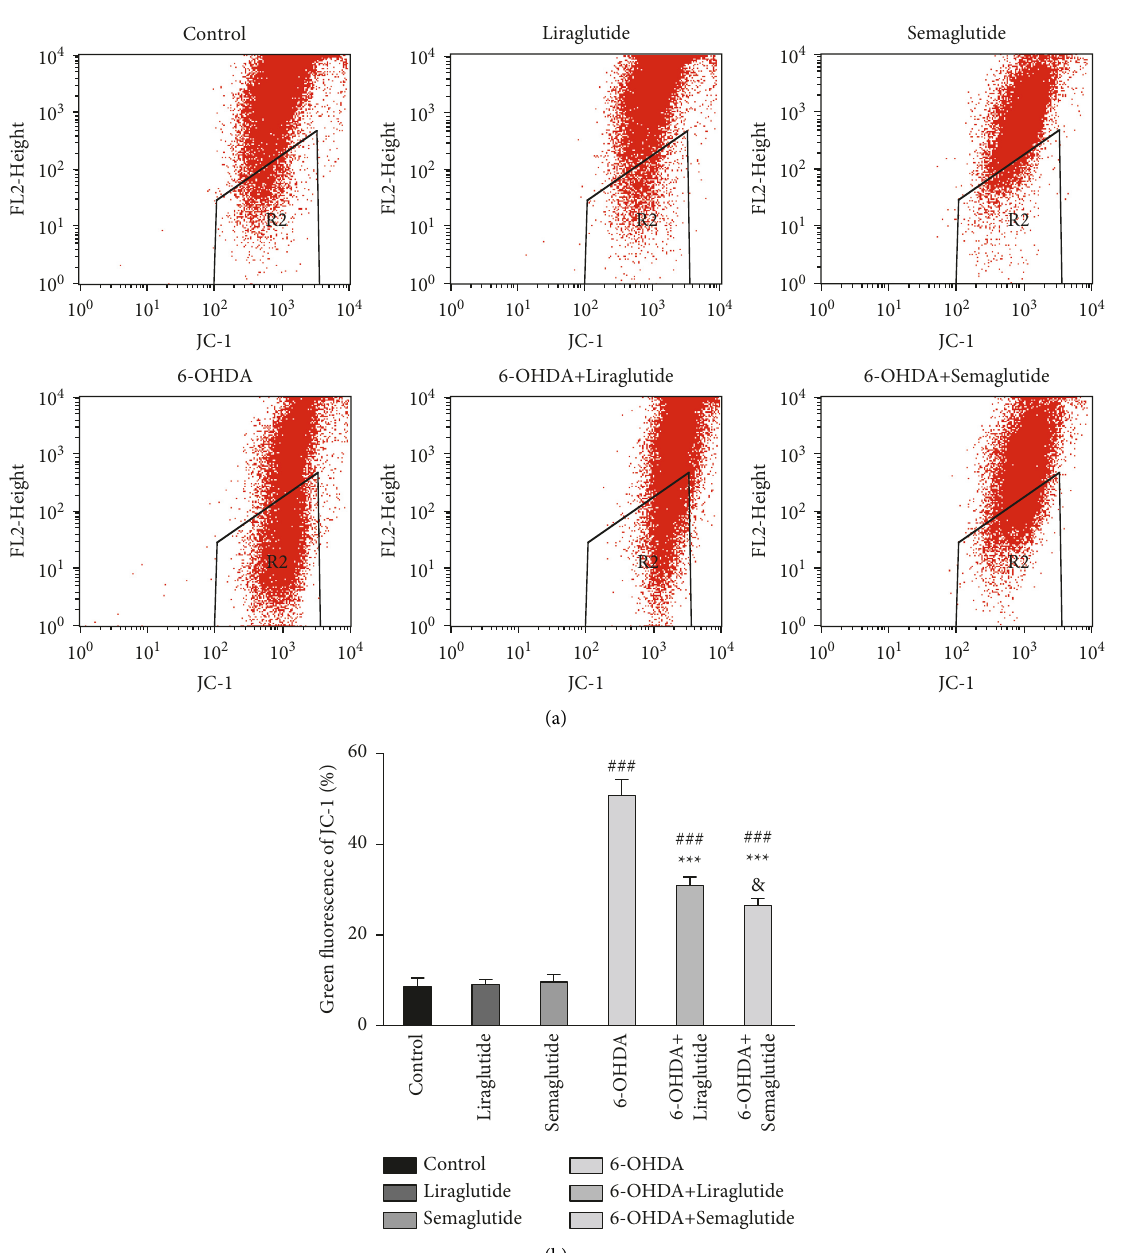
Figure 4: Changes in the m levels in SH-SY5Y cells. (a) Detection of the percentage of green fluorescence of JC-1 by flow cytometry. Green fluorescence indicates a low mitochondrial membrane potential ( OHDA group (### P 0 . 001 vs. the control group). Semaglutide and liraglutide normalized the green fluorescence of JC-1 ( ΔΨ 6-OHDA group) and semaglutide was significantly more effective ( & P mean standard deviation ( n < (cid:30) ±